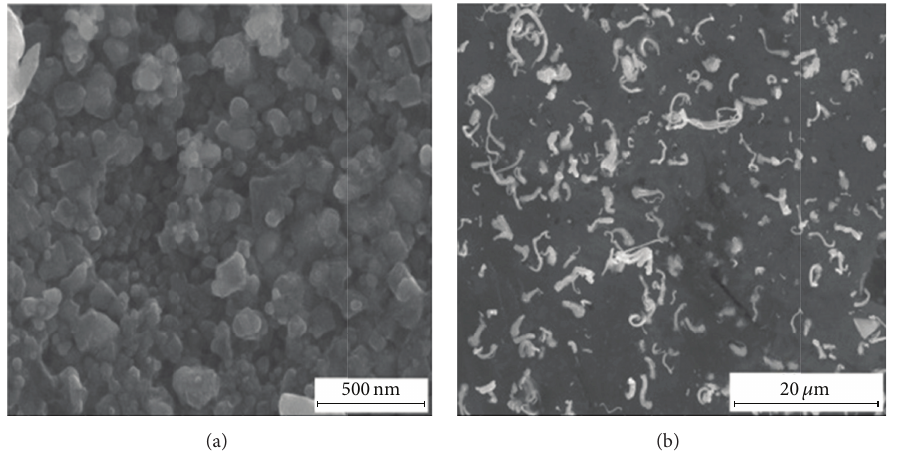
Figure 9: SEM photographs of nanosilver prepared on the basis of the dog rose extract: (a) system 1, (b) system 7.